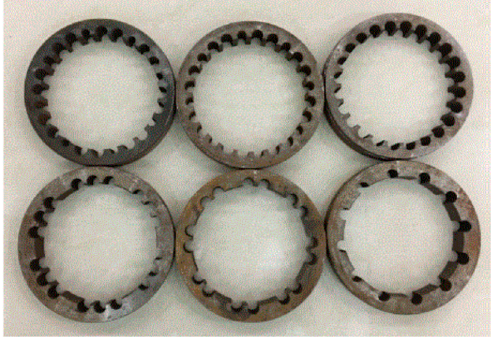
Figure 1. Static cutter models with different degrees of clogging [4].